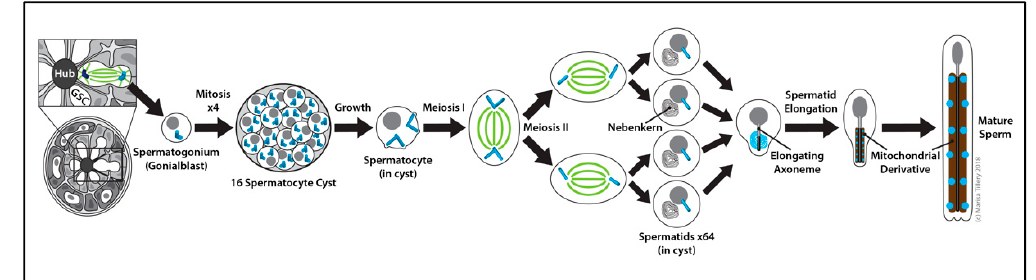
Figure 5. Spermatogenesis. Spermatogenic germline stem cells reside at a niche called the hub where divisions are polarized and asymmetric, producing spermatogonia. Spermatogonia divide four times to produce a cyst of 16 spermatocytes. Spermatocytes assemble short cilia from each of their four centrioles during G2 phase and retain them as they undergo two meiotic divisions to produce sixty-four haploid spermatids. Spermatids assemble an axoneme in their cytoplasm and the mitochondria fuse into two large mitochondrial derivatives upon which ncMTOCs assemble. Nuclei are grey; MTs are green; mitochondria are brown; MTOCs (centrosomes and ncMTOCs on the mitochondrial derivative) are blue.